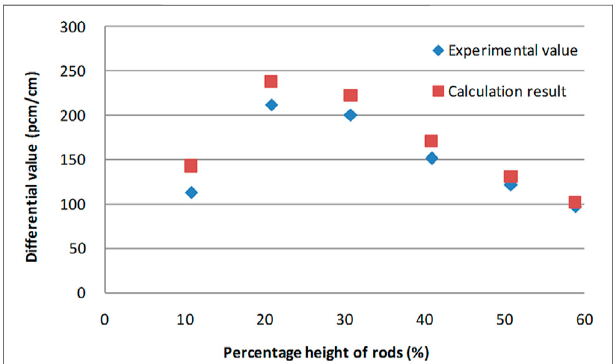
FIGURE 14 | Differential value curve of C rod group (Scheme 8).